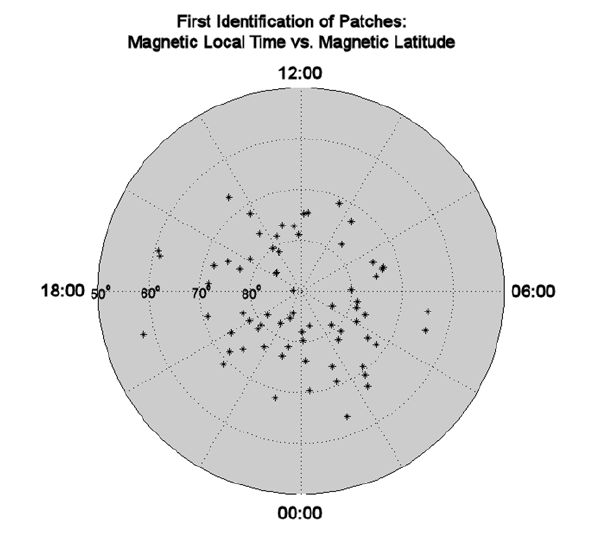
Fig. 11. The magnetic local time (angular axis) versus magnetic latitude (decreasing from the centre). Although significant time may have passed between formation and first detection, a bias against formation during the 06:00 to 12:00 quadrant is